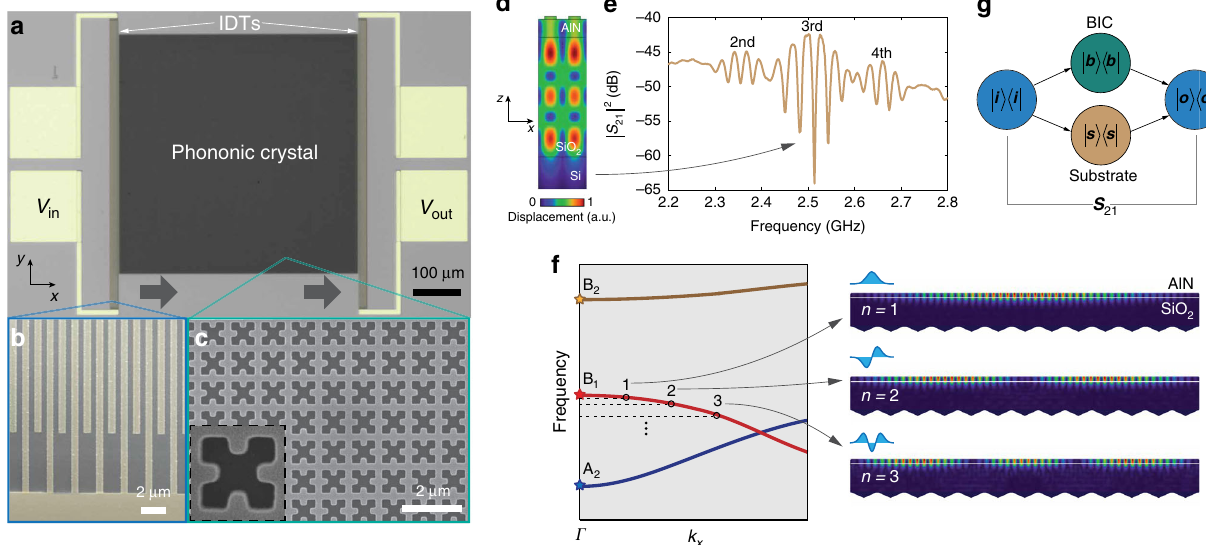
Fig. 2 Piezoelectric detection of mechanical BICs. a False-color optical microscopy image of a device consisting of a PnC with 500 × 500 unit cells and a pair of IDTs with electrodes. b , c Scanning electron microscopy images of the IDT fi ngers ( b false-color) and the PnC ( c ). d Simulated modal pro fi le of the third-order AlN-SiO 2 eigenmode. e Measured transmission spectrum via a pair of IDTs. f Formation of standing-wave resonances near the band edge in fi nite-size PnCs and the simulated modal pro fi le of the fi rst three band-edge modes formed from the B measurement